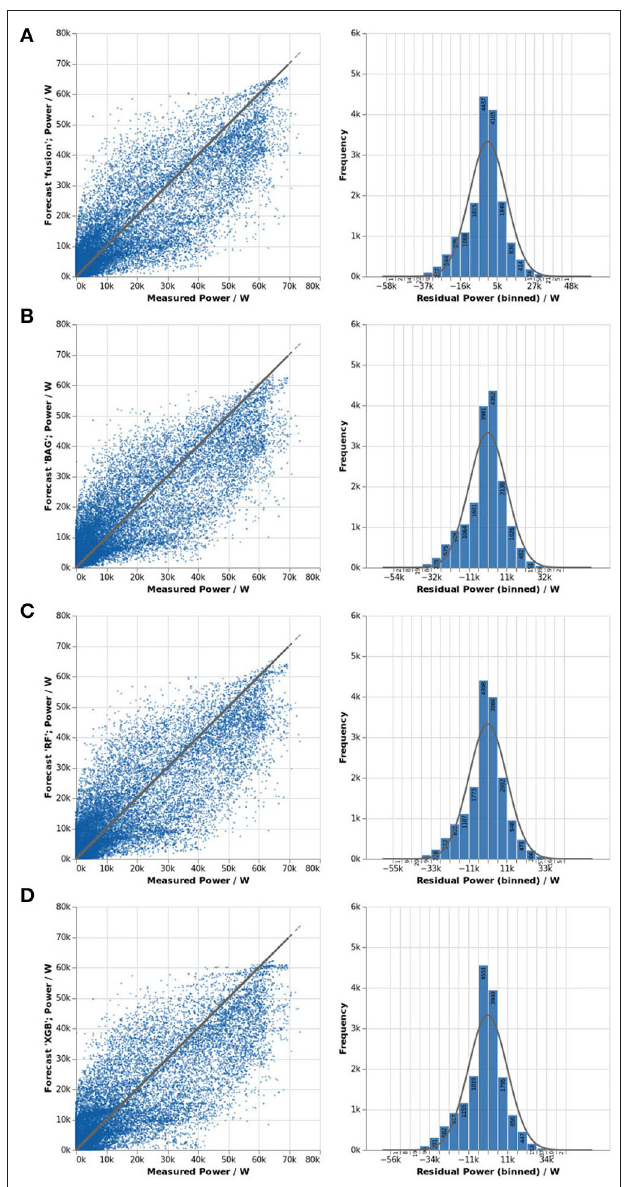
FIGURE 6 | Forecast quality of the power forecast for site swsls-sw for 2019: fusion (A) , BAG (B) , RF (C) , and XGB (D) .